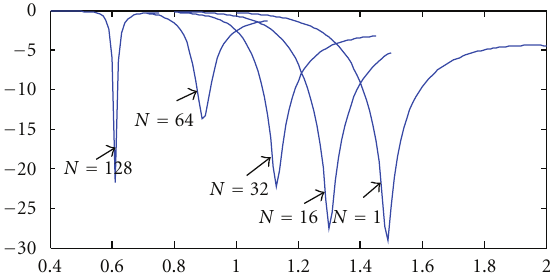
Figure 2: Simulated input return loss of these antennas.